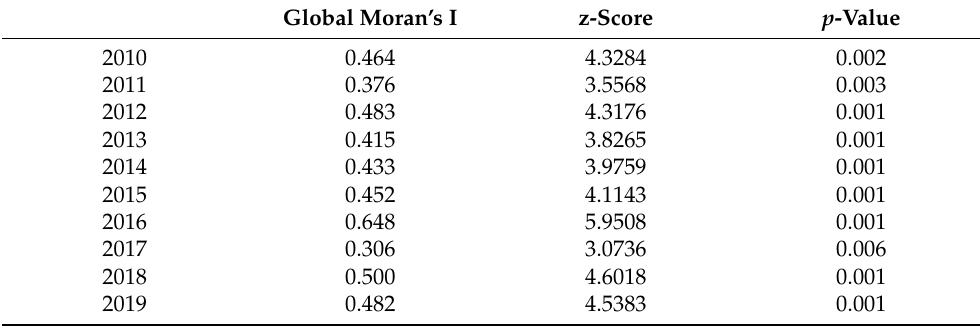
Table 2. Moran’s I index of the MSW treatment carbon emission efficiency in China during